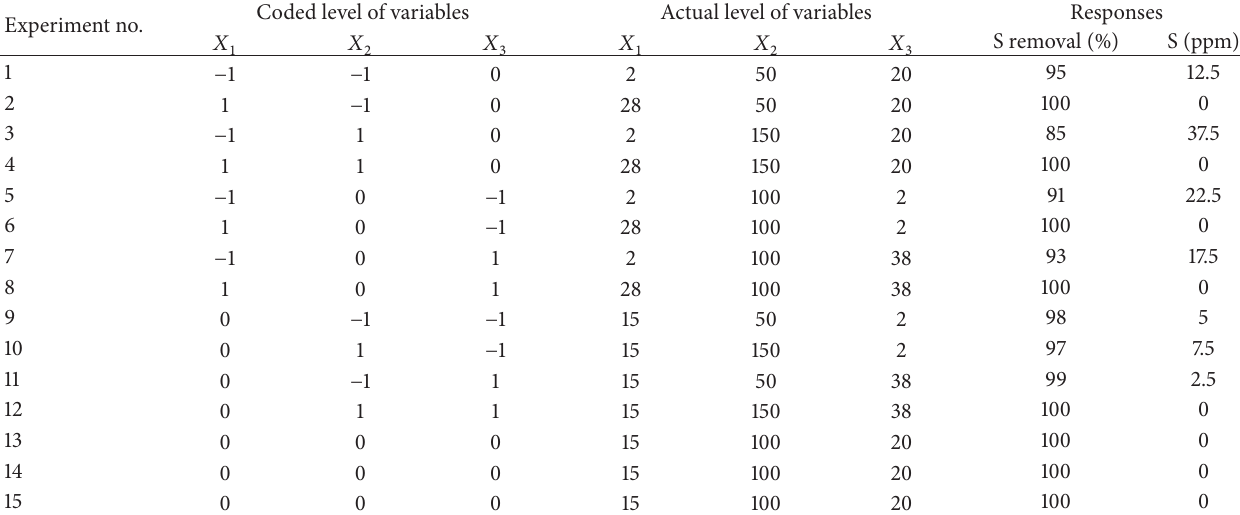
Table 3: Coded and actual levels of variables with corresponding responses (initial sulfur concentration = 250ppmw). Experiment no.